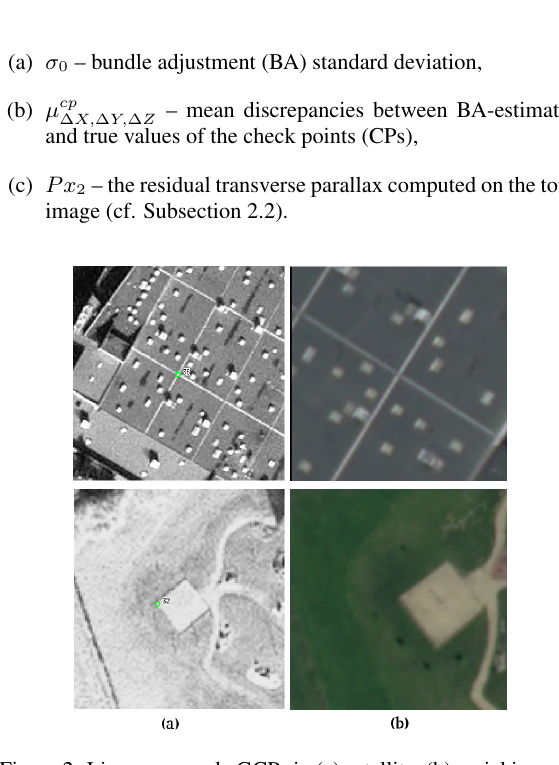
Figure 2: Limoge; sample GCPs in (a) satellite, (b) aerial images.